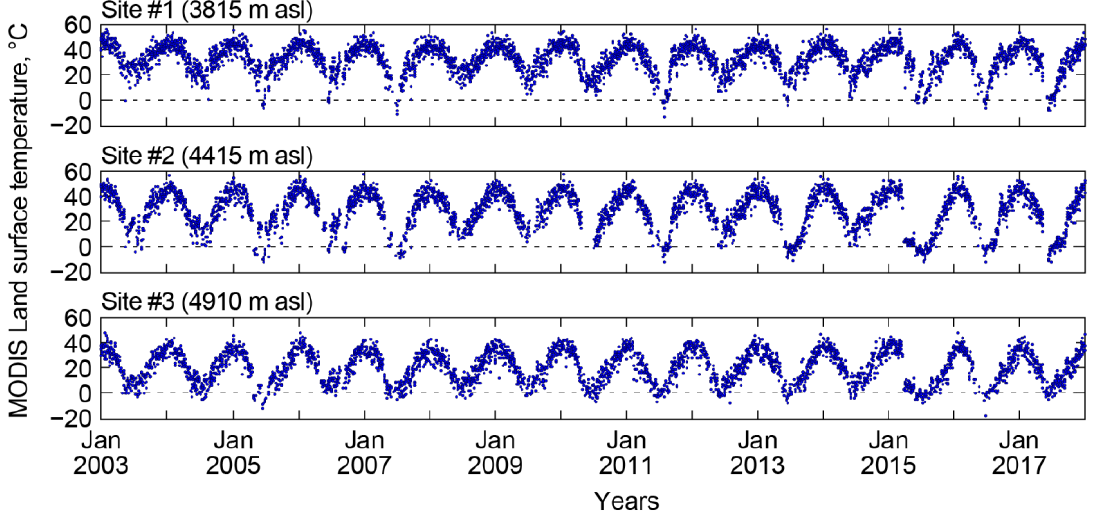
Figure 4. MODIS land surface temperatures at 2 PM (local) from 2003 to 2017 for the three validation Figure4. sites.